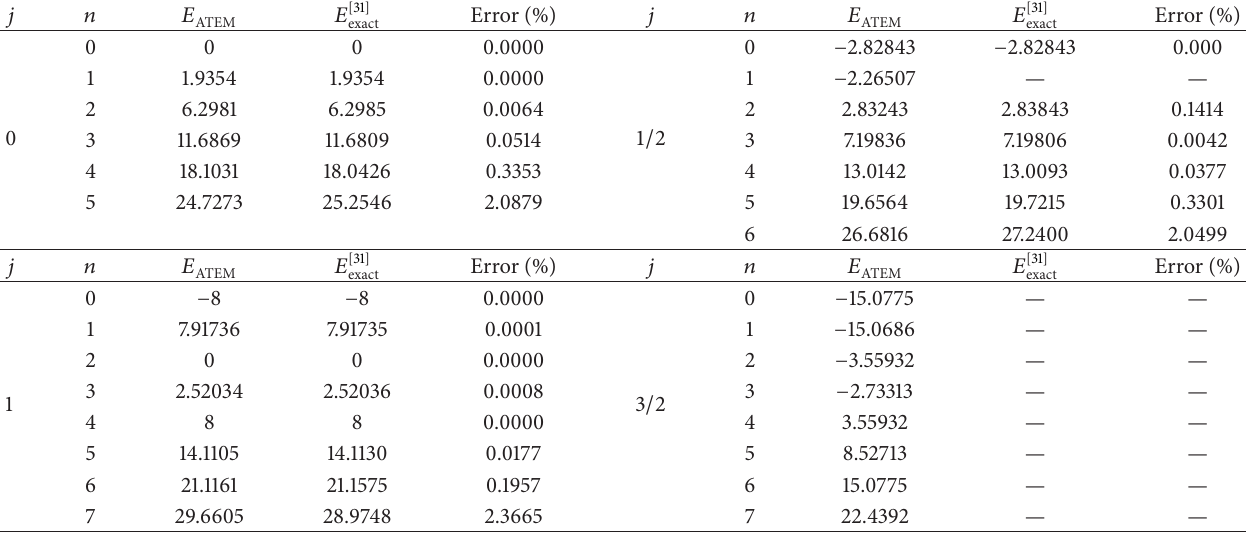
Table 4: Comparison of the first few energy eigenvalues of potential in (17) with different values of 𝑗 . The percent errors for ATEM are also shown in the fifth and tenth columns.